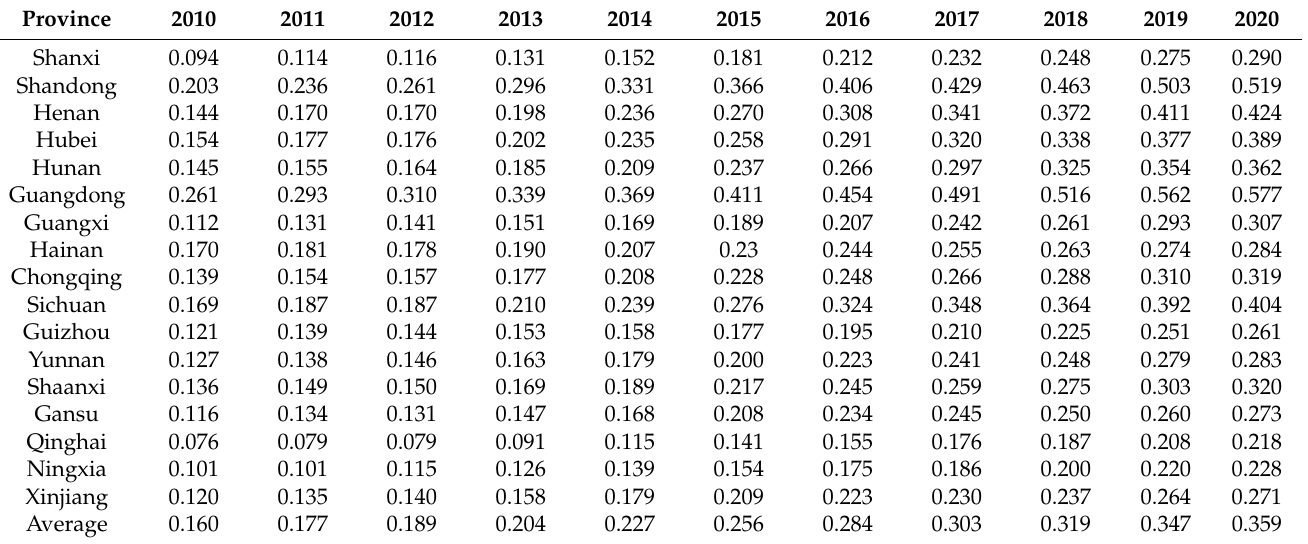
Figure 2. Spatiotemporal differentiation diagram of energy utilization level. Note: The islands in the South China Sea are not shown in the figure. 4.2. PVAR Model Dynamic Relationship Analyze To clarify the dynamic relationship between a green economy and energy utilization level, we employed the PVAR model to conduct our analysis. After calculating the value of a green economy and energy utilization levels, the variables were examined in the order